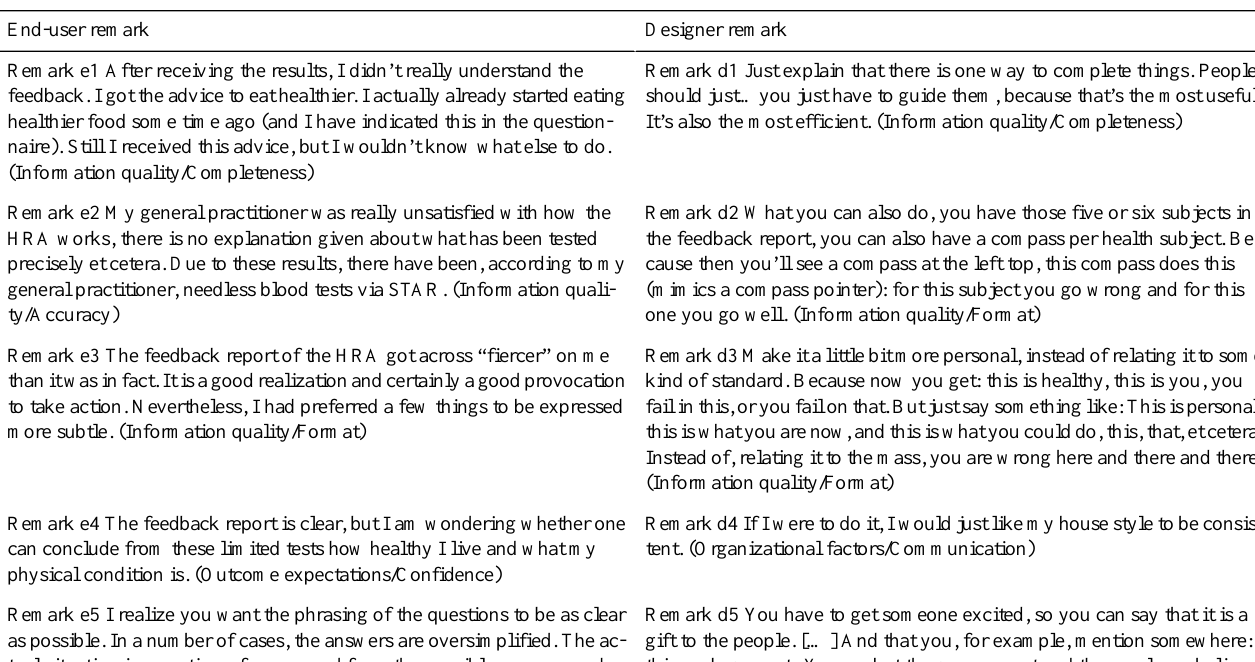
Table 2. Examples of end-users’remarks and designers’remarks to illustrate the differences in yield of the two evaluation methods.